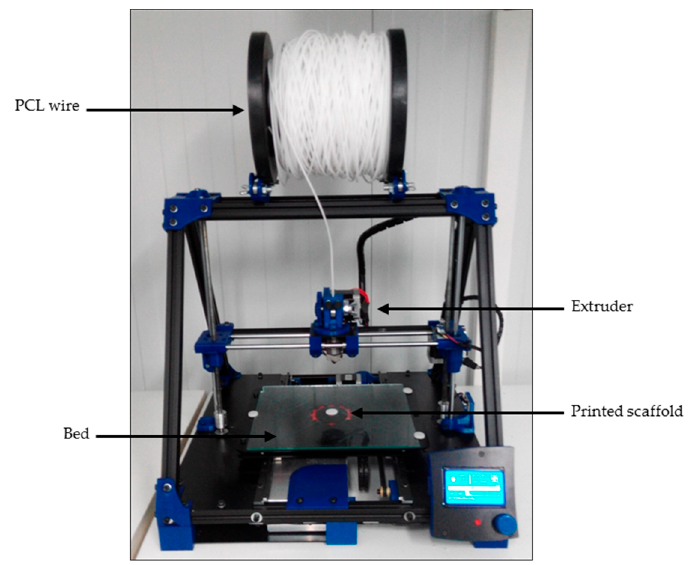
Figure 2. RepRap BCN 3D+ printer with a 3 mm PCL wire.